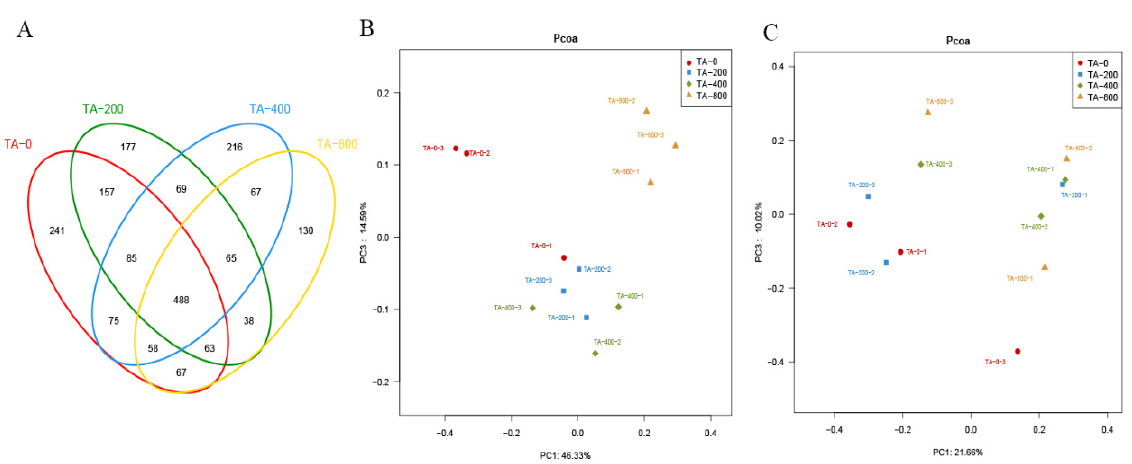
Figure 7. Intestinal microbial diversity and composition of L. vannamei that were fed the control and TA diets for 56 days. ( A ) The number of unique and shared OTUs between different treatments indicated by the Venn diagram. ( B ) PCoA plots based on weighted Unifrac metrics. ( C ) PCoA plots based on unweighted UniFrac metrics.